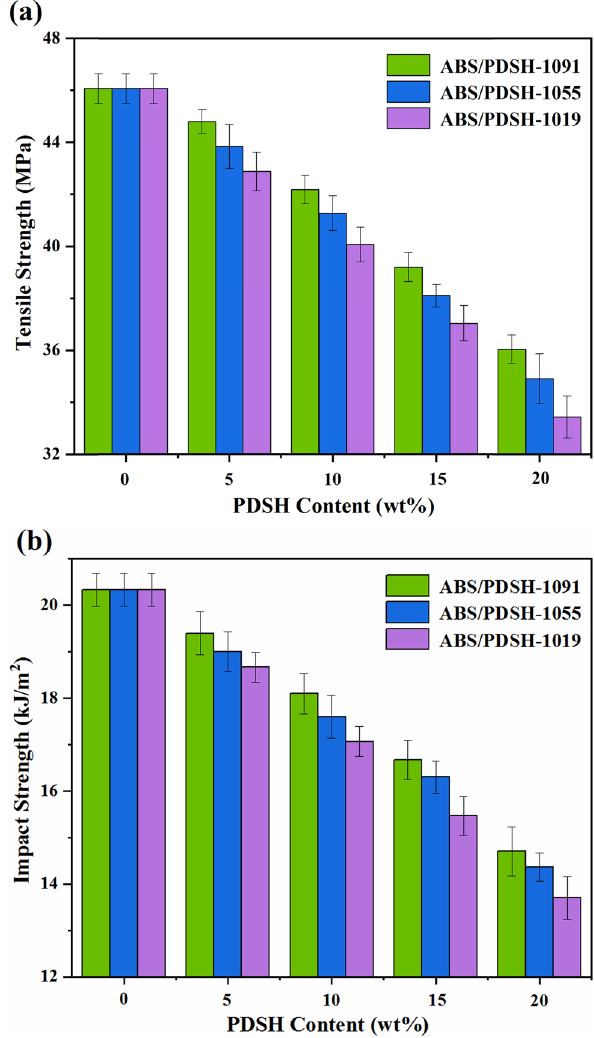
Figure 9: In fl uence of the PDSH content on the mechanical proper - ties of ABS/PDSH composites: ( a ) tensile strength and ( b ) impact